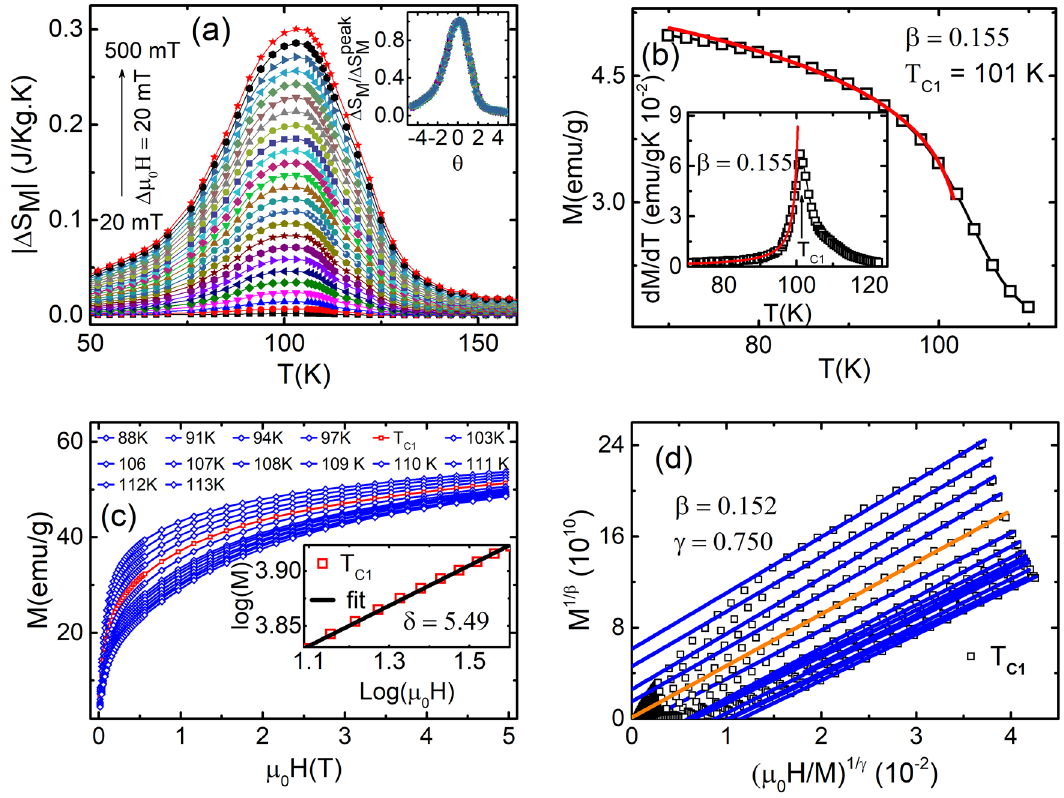
Figure 5. ( a ) Magnetic entropy change (cid:31) S M versus temperature T at different applied magnetic fields ranging from 20 to 500 mT determined by M-H curve for temperature range 50–160 K in step of 3 K, which shows a continuous non-monotonic change of (cid:31) S M around T C 1 . Inset is normalized entropy change as a function of the rescaled temperature θ for BL-LSMO-0.3. The collapse of all the curves on a single universal curve confirms second-order phase transition. ( b ) Magnetization versus temperature around T C 1 for temperature range 5–160 K. Inset is the derivative of magnetization showing a transition at T C 1 . Its fitting with Eq. (8) gives β = 0.155. ( c ) Isothermal M-H for applied magnetic field range 0–5 T. Inset is the log – log plot of the isothermal M-H at T C 1 with fitting the log of Eq. (7), which gives the value of exponent δ = 5.49. ( d ) MAPs for the M-H of ( c